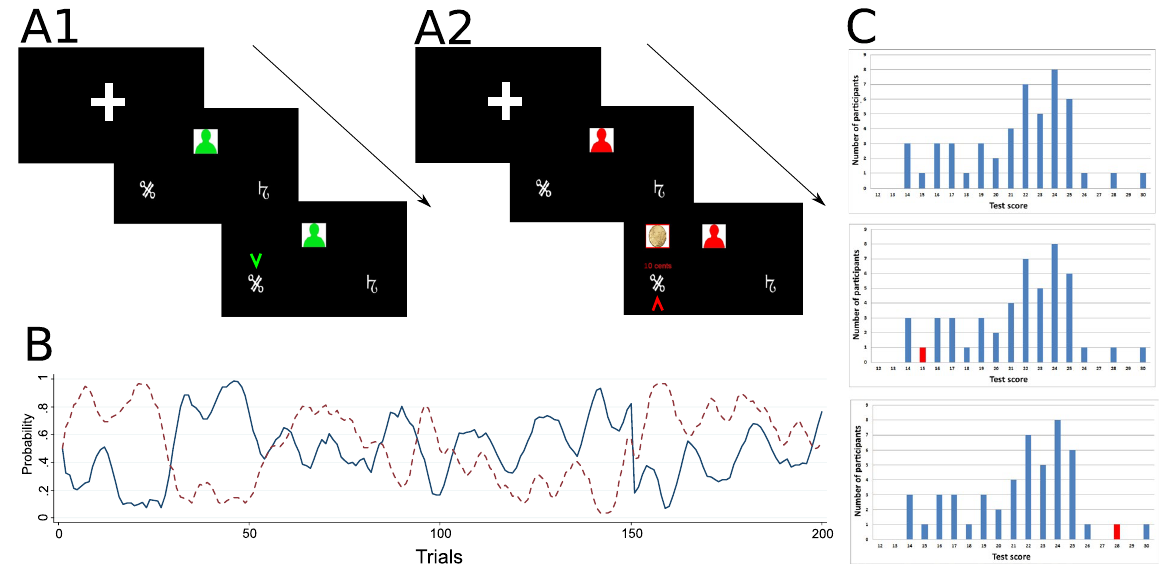
Figure 1. Experimental design. ( A ) Participants choose between two options which can give them a 10 cents reward with some probability (A2). In each trial, a red figurine, presented after a fixation screen, informs participants that it is time to choose. In Experiment 1 participants choose without observing anyone’s choices. In Experiments 2 and 3, periodically (6–12 trials in a row, for a total of 100 out of 200 trials across the experiment), and before their choice, participants can observe the choice of another participant who took part in Experiment 1 (A1). The observed other is represented by a green figurine and her choice is shown with a green tick. Participants do not observe the outcome of that choice. ( B ) Throughout the 200 trials of the experiment the probabilities of reward from the two arms change according to prespecified random processes (the two lines on the graph). It was carefully explained to participants in Experiments 2 and 3 that these probabilities were the same for them and the demonstrator they observe. ( C ) Participants in Experiments 2 and 3 received different information on the observed other. In the NovisHigh and NovisLow treatments they see only the distribution of the Raven scores of potential demonstrators (graph at the top). In the VisHigh and VisLow treatments they see the distribution and the Raven score of the other they observe marked by a red bar (graph in the middle and at the bottom). In Experiment 2 all participants know their own Raven score.